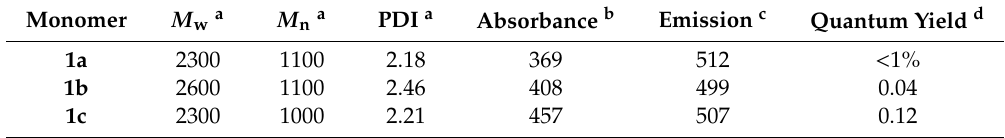
Table 2. Properties of weight, absorbance, and fluorescence of polymers prepared by chemical oxidation.